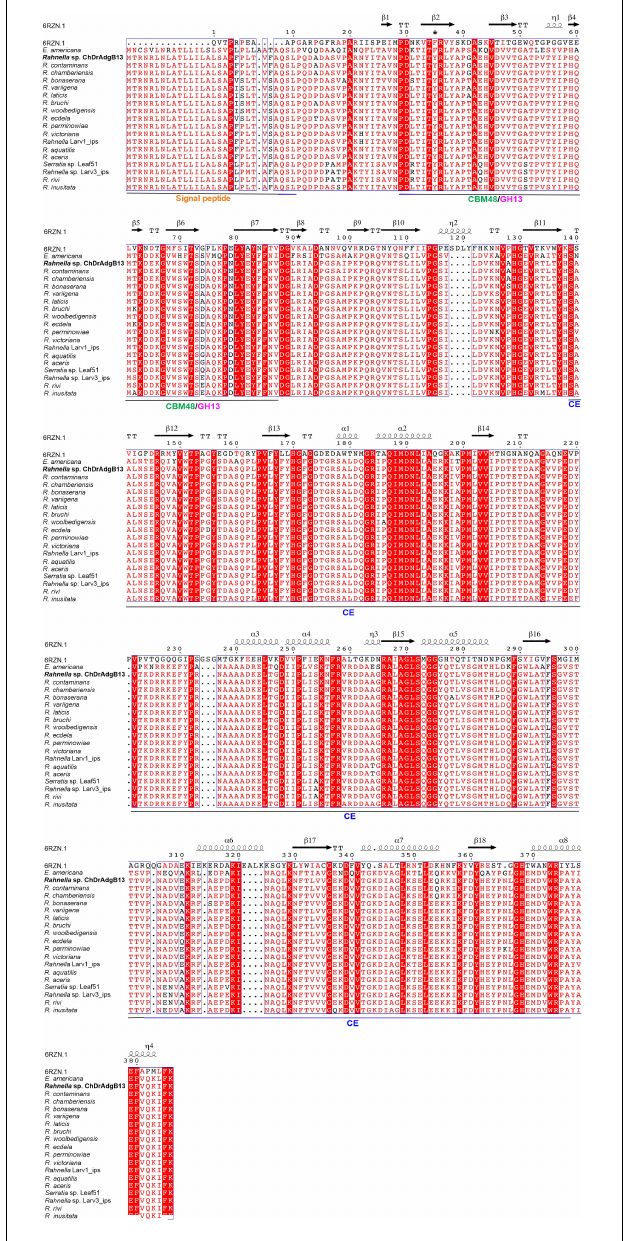
FIGURE 2 | Multiple sequence alignment and secondary structure element assignment. The alignment included crystal structure from ferulic